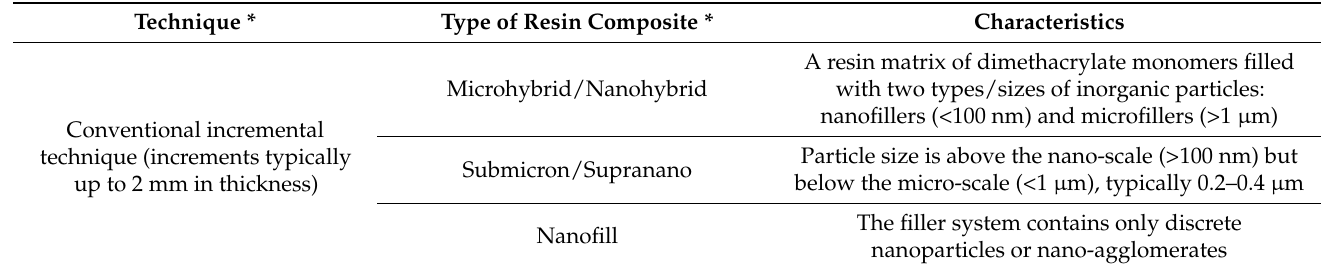
Table 2. Characteristics of resin composites used for posterior